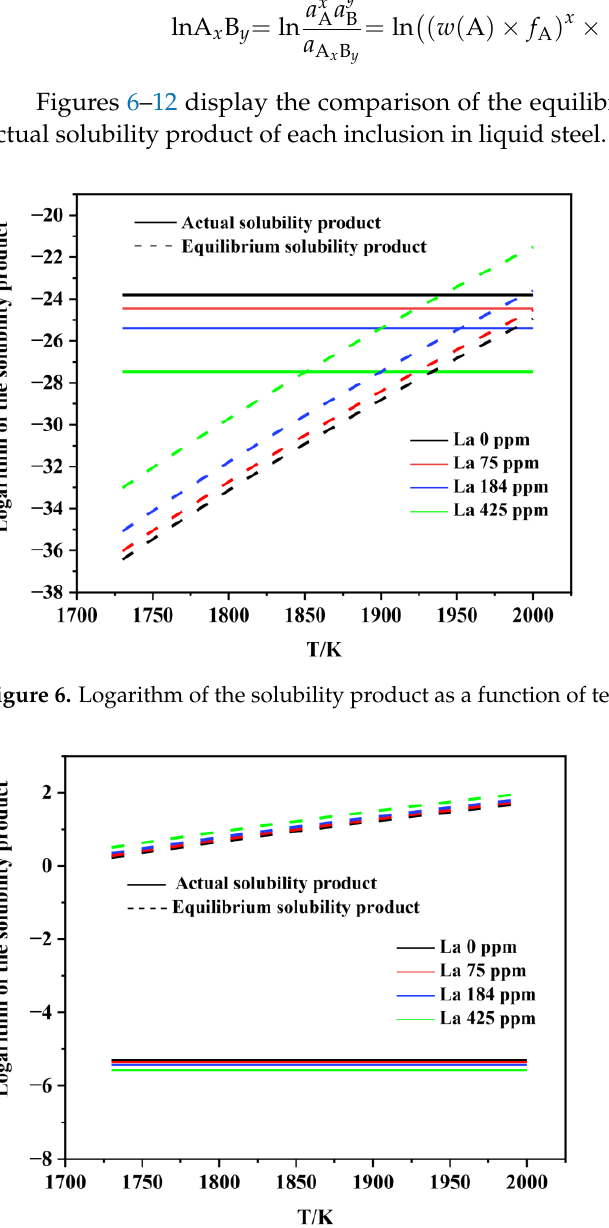
Figure 7. Logarithm of the solubility product as a function of temperature for MnS in liquid steel.